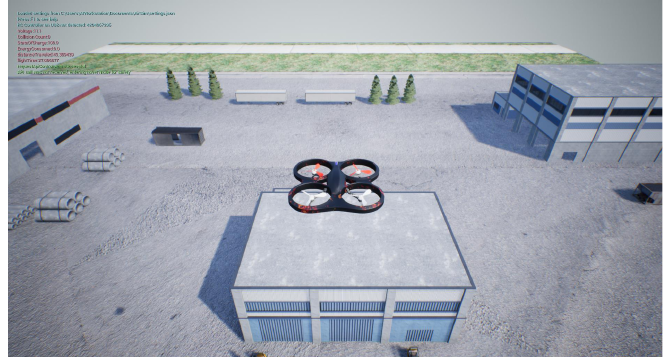
Figure 4. Screenshots of the block (static) environment.